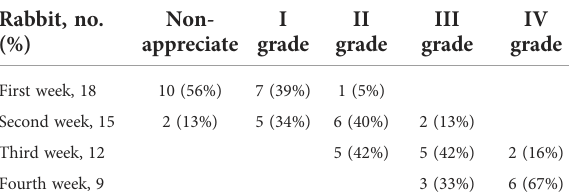
TABLE 2 Degree of airway stenosis in different weeks after tumor implantation. Rabbit, no.